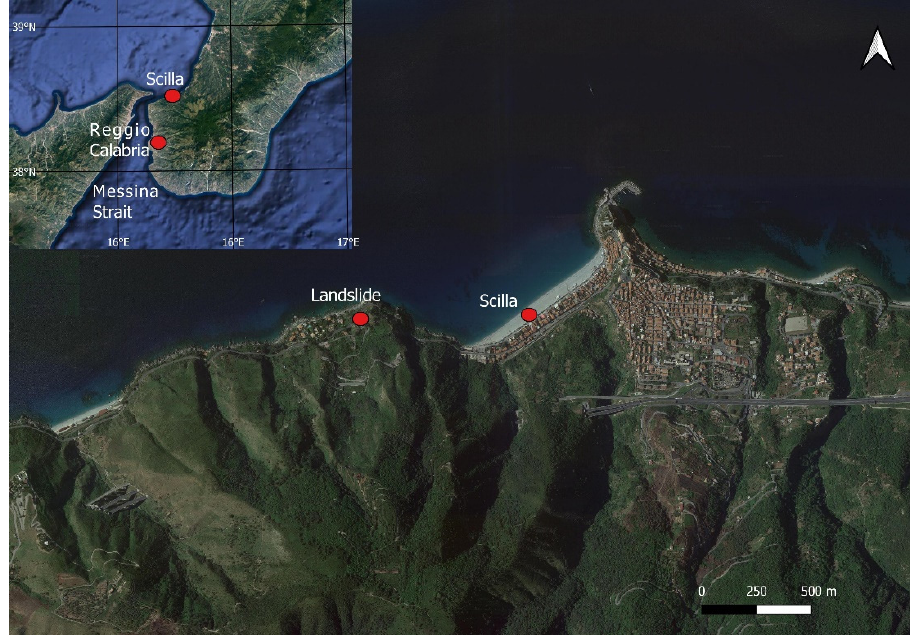
Figure 2. Location of the landslide triggered by the earthquake followed by the tsunami (source QGIS).